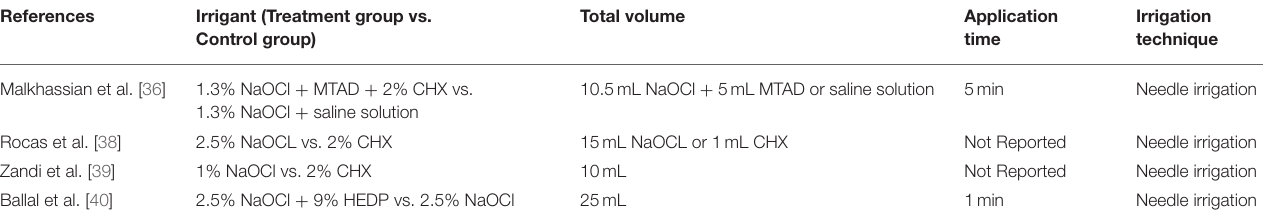
TABLE 3 | Studies comparing irrigating